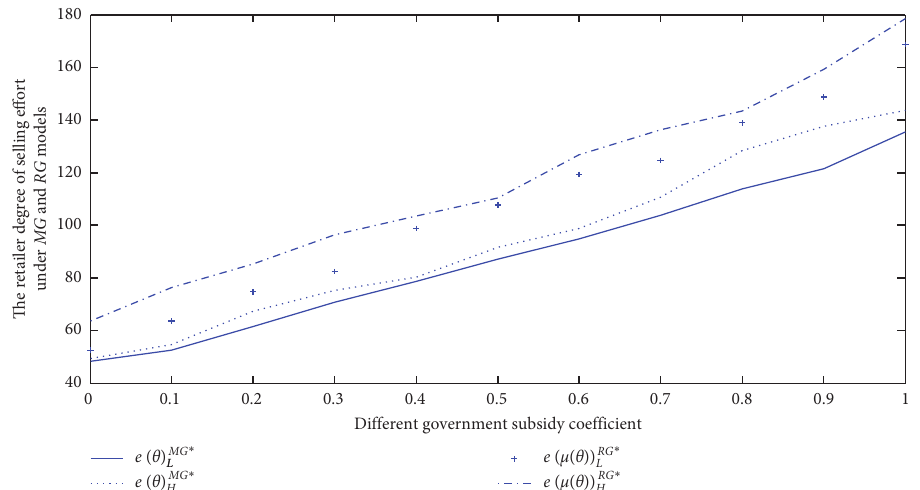
Figure 5: The impact of different government subsidy coefficients on retailer’s level of selling effort under two models.